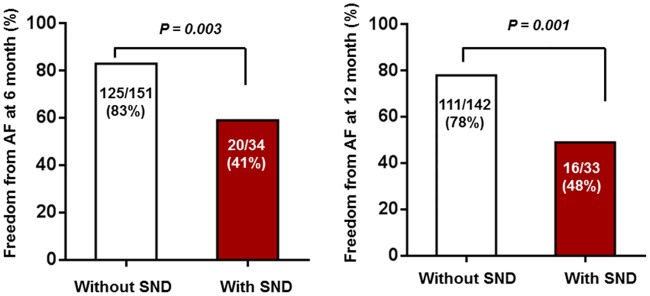
Freedom from AF at the 6-month and 12-months follow ups.Percentages of patients who were free from AF at the 6-month and 12-month follow-ups.